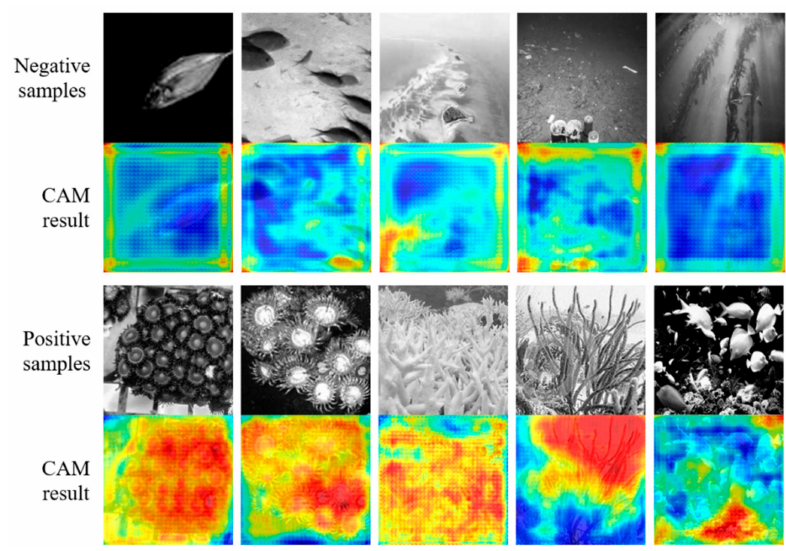
Figure 10. Validation set samples and activation